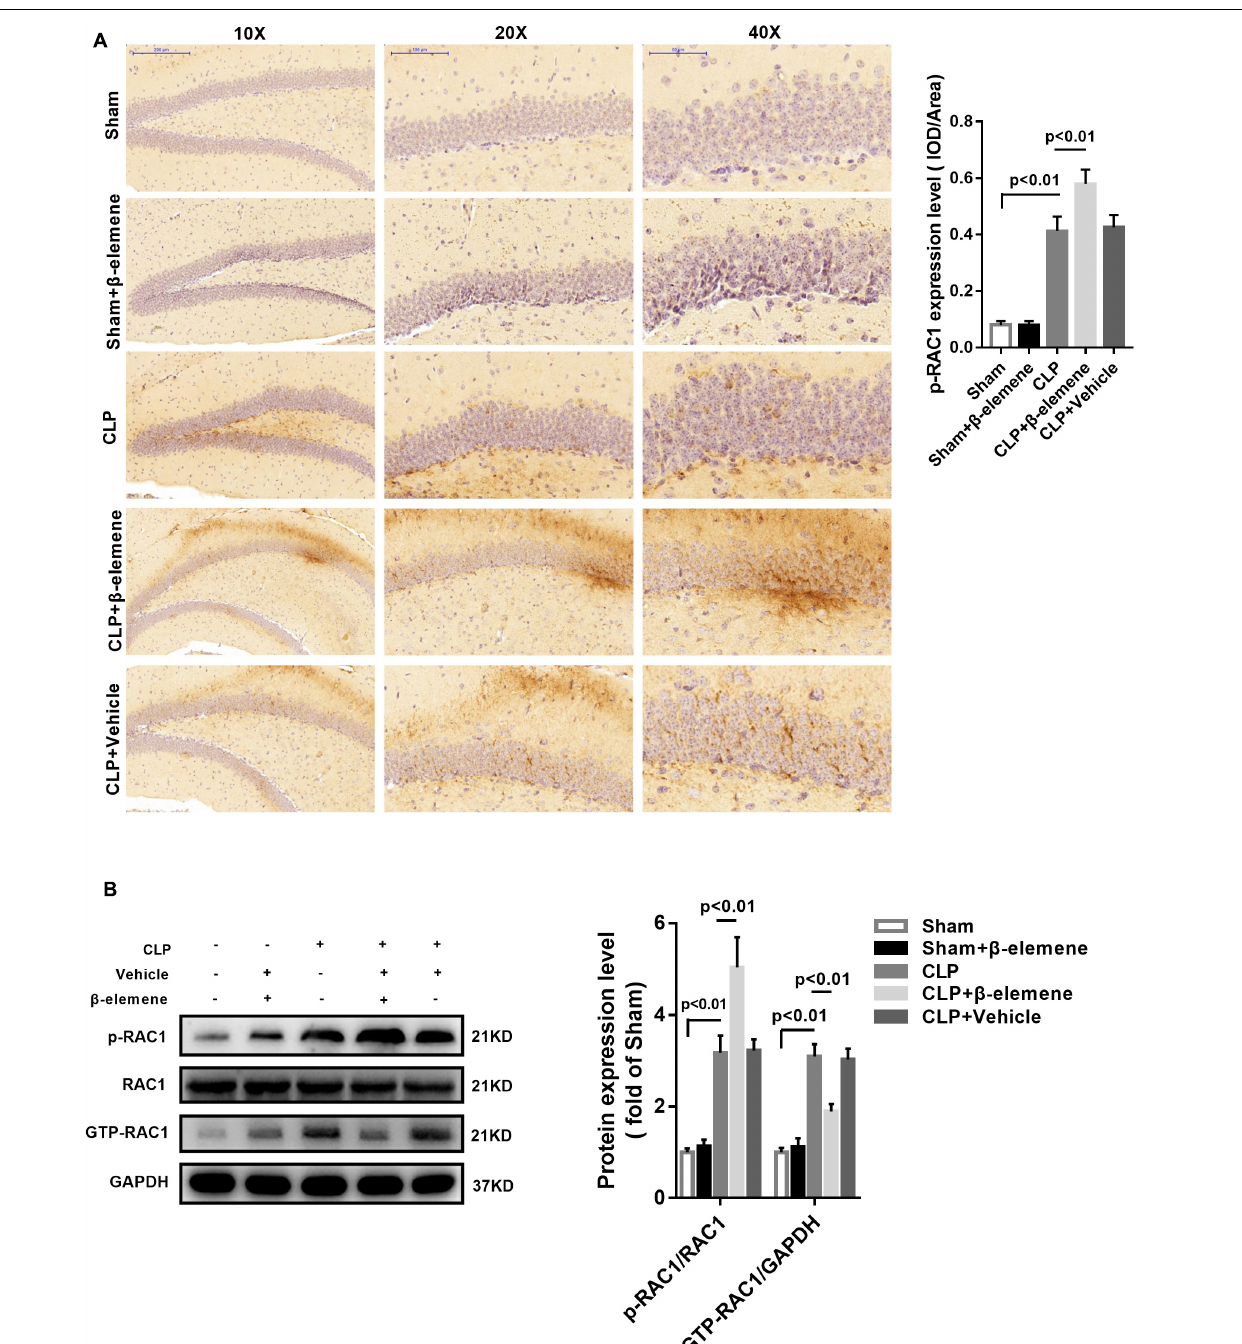
FIGURE 6 | β -Elemene increased the RAC1 phosphorylation in the mouse hippocampus. (A) Immunohistochemical staining showed that β -elemene significantly facilitated RAC1 phosphorylation. F(4, 15) = 102. (B) Western blotting exhibited that β -elemene significantly increased RAC1 phosphorylation [F(4, 15) = 72.76] and decreased GTP-RAC1 [F(4, 15) = 63.42] detected by western blotting in the hippocampus. Phosphorylation of RAC1 was normalized to that of RAC1. GTP-RAC1 expression was normalized to that of GAPDH. n = 4. One-way ANOVA revealed a significant difference at p < 0.05.